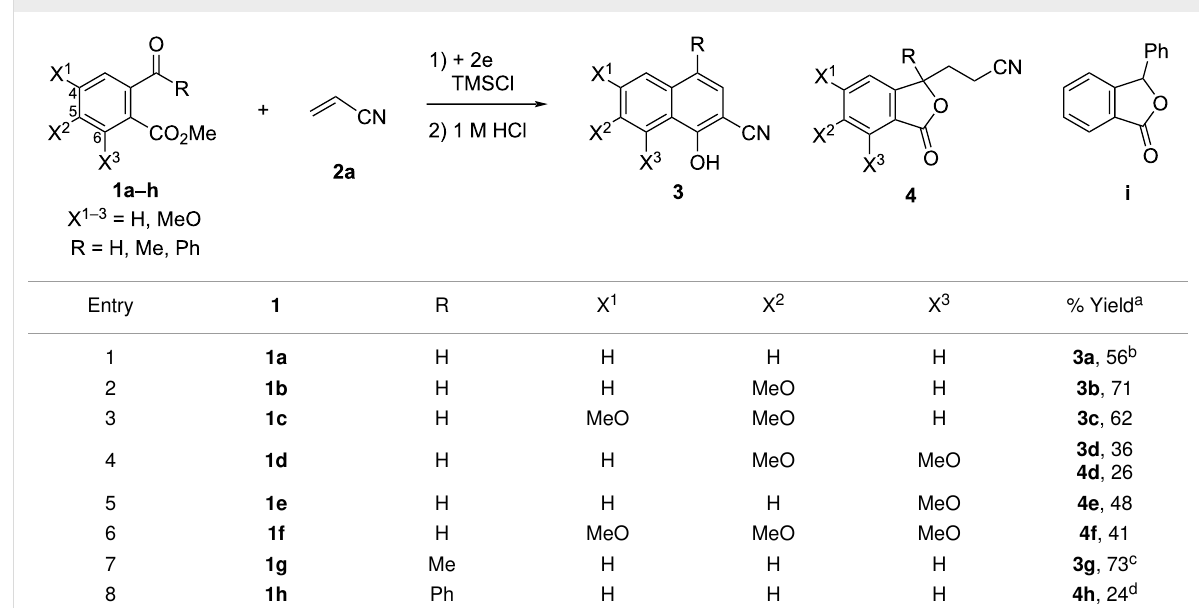
Table 1: Electroreductive coupling of 1a–h with 2a and subsequent treatment with 1 M HCl.